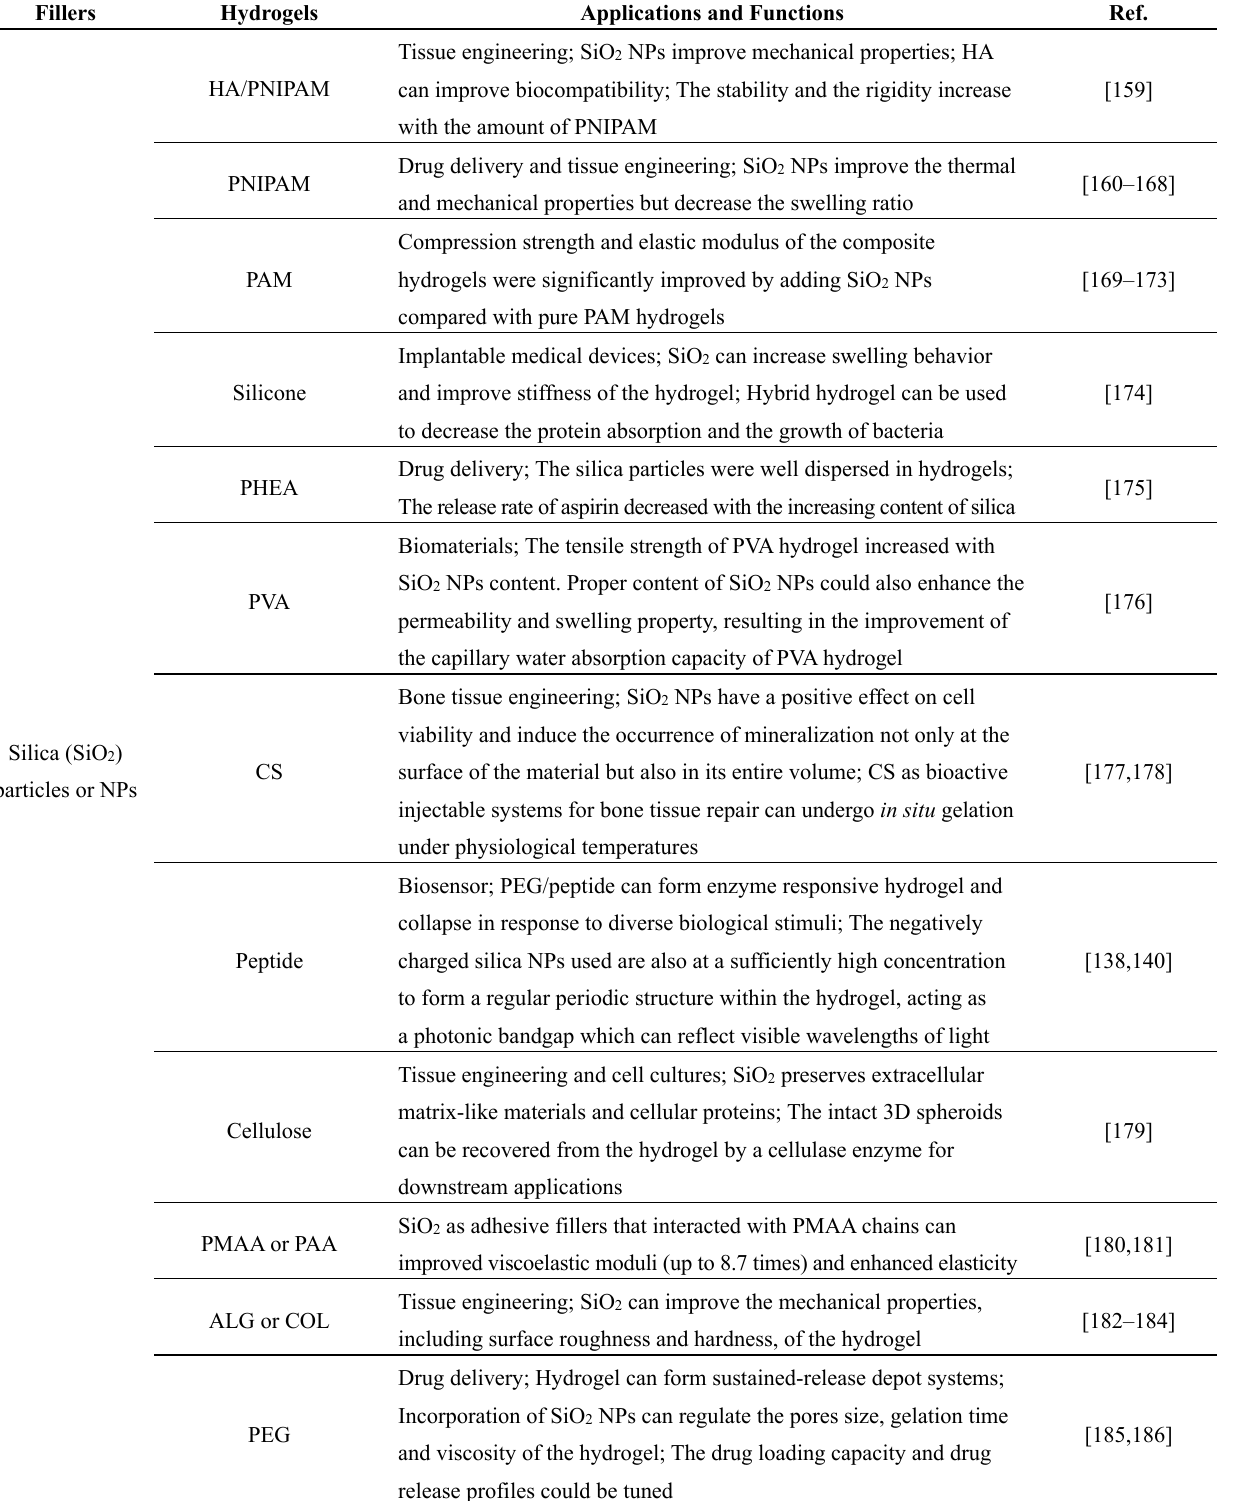
Table 2. Summary of nanocomposite hydrogels from hydrogels and silicon-based NPs for biomedical